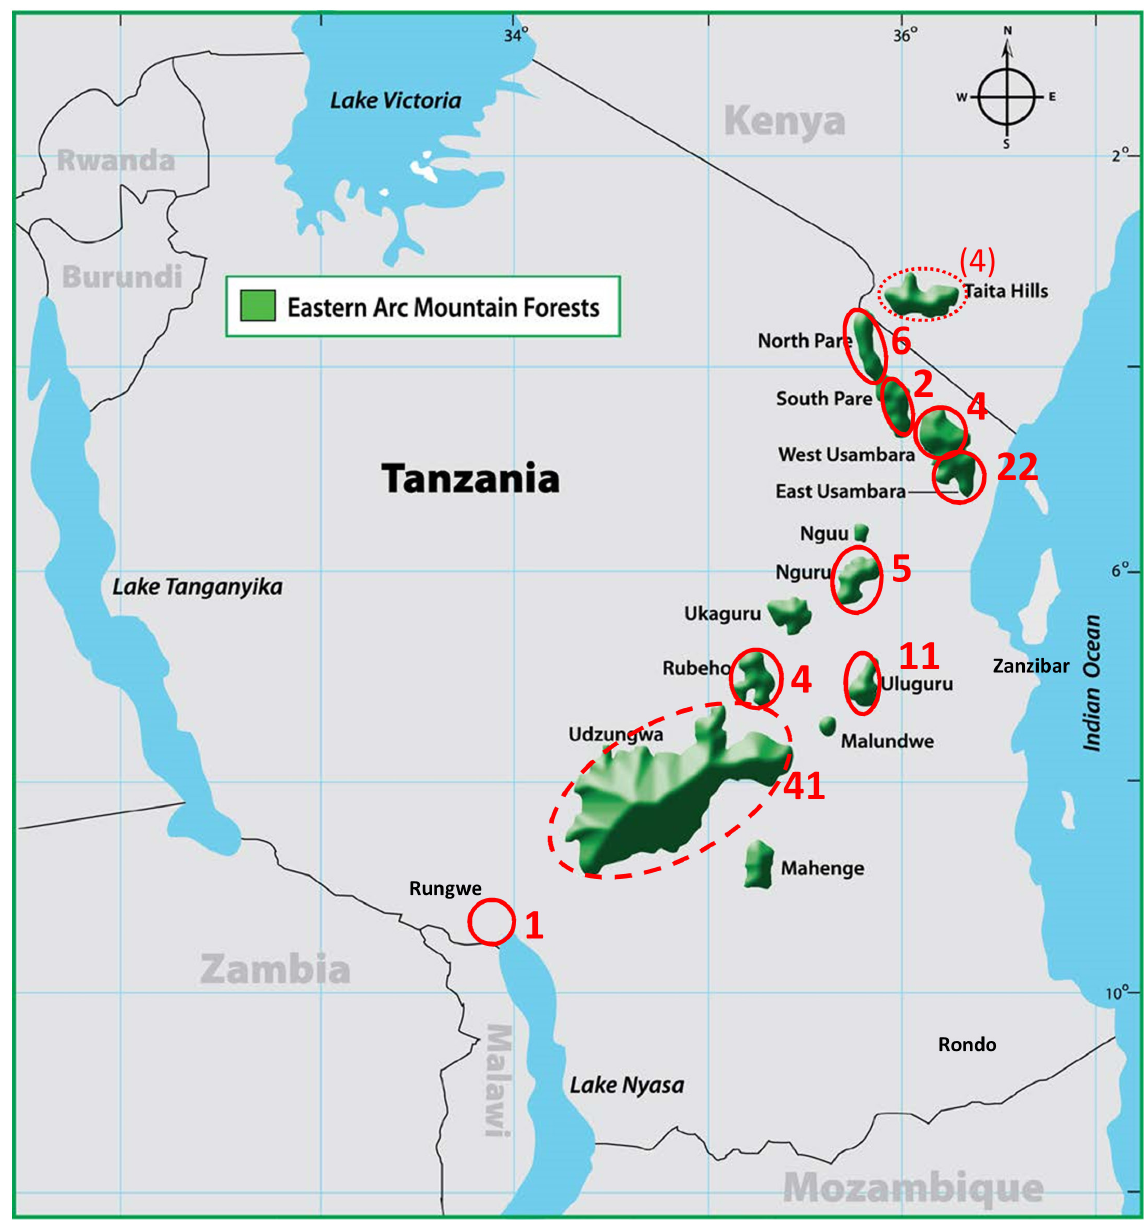
Fig. 2. The Eastern Arc Mountains, with numbers of species of Odontopygidae known from each mountain block. The odontopygids of the Taita Hills in Kenya are not covered by the present work, and those of the Udzungwa Mts are only marginally covered. Base map by permission of the Eastern Arc Mountains Conservation Endowment